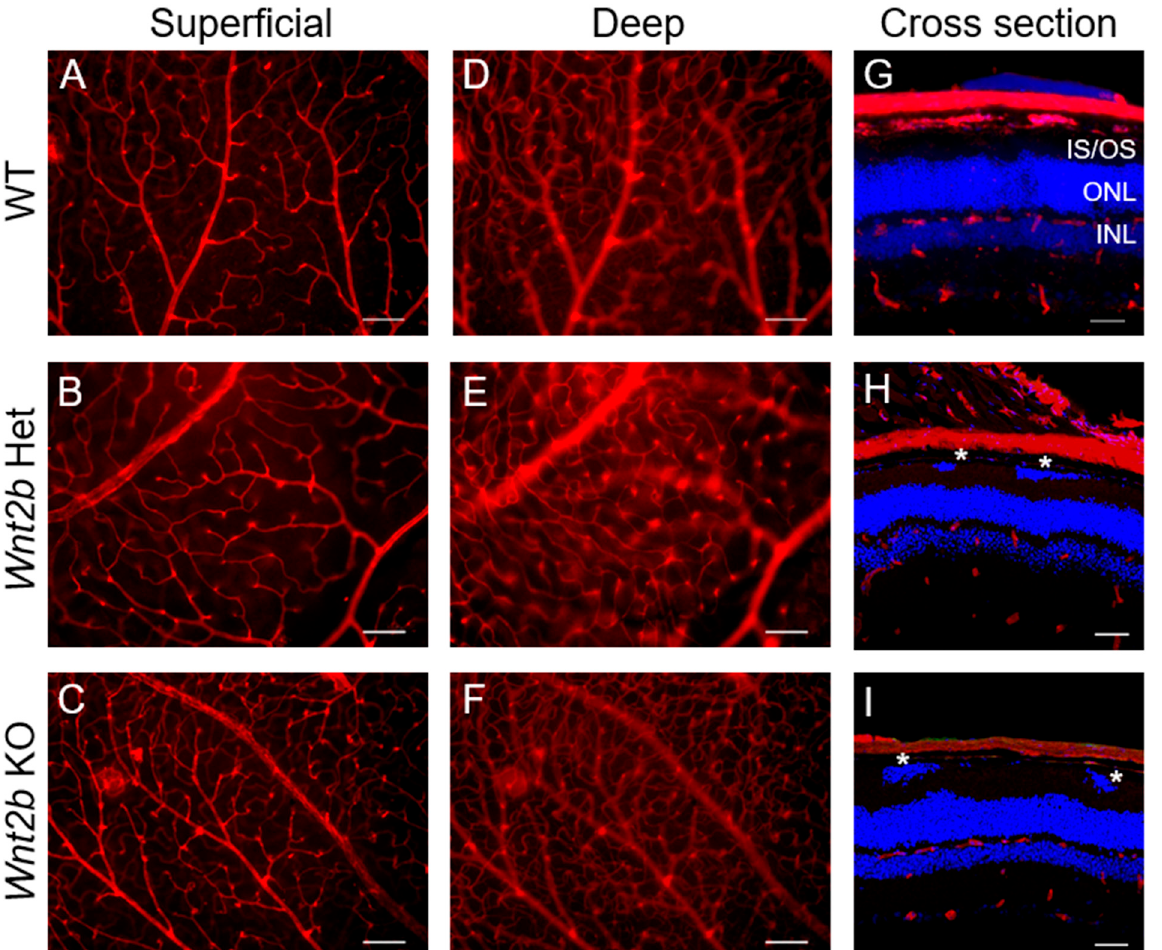
Figure 2. Wnt2b KO mice exhibit normal retinal vasculature. ( A – F ) Retinal flat mounts stained with isolectin (red) showing normal vasculature of young adult WT ( A , D ) Wnt2b Het ( B , E ) and KO ( C , F ) mice. Images ( A – C ) show superficial layer and ( D – F ) show deep layer vessels. Scale bars: 100 µm. ( G – I ) Retinal cross sections from young adult mice were stained with isolectin (red) and counterstained with DAPI (blue) and showed fully formed and normal vascular layers (superficial, intermediate, and deep). Scale bars: 50 µm. * indicates ectopic nuclei in IS/OS. IS/OS: inner segments/outer segments; ONL: outer nuclear layer; INL: inner nuclear layer.